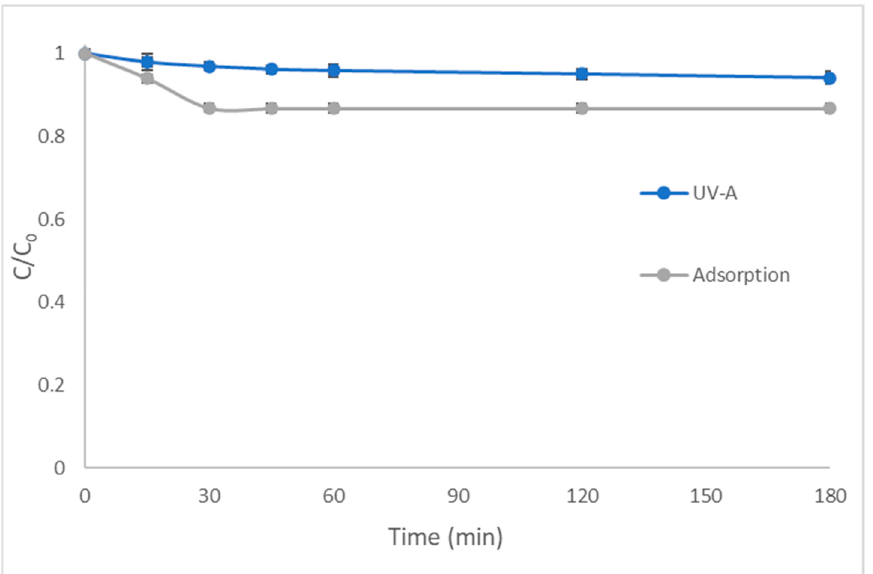
Figure 1. Adsorption and UV-A photolysis of amisulpride in UW ([amisulpride] 0 = 1 mg L − 1 ; [g-C 3 N 4 ] = 300 mg L − 1 ).